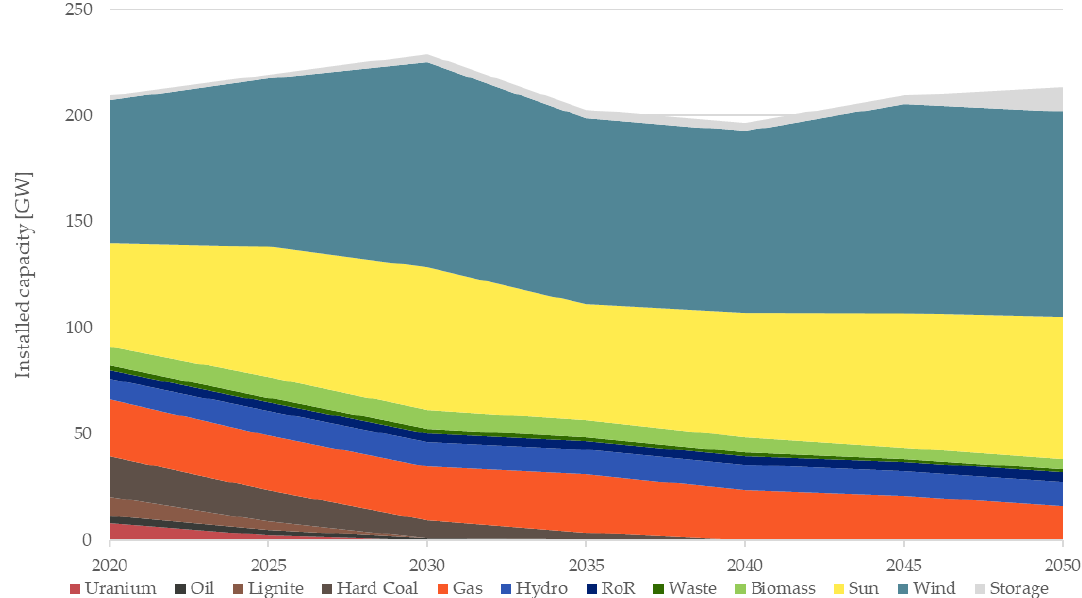
Figure 3. Installed capacity pathways for the RAPID exit over the model horizon (own calculations).